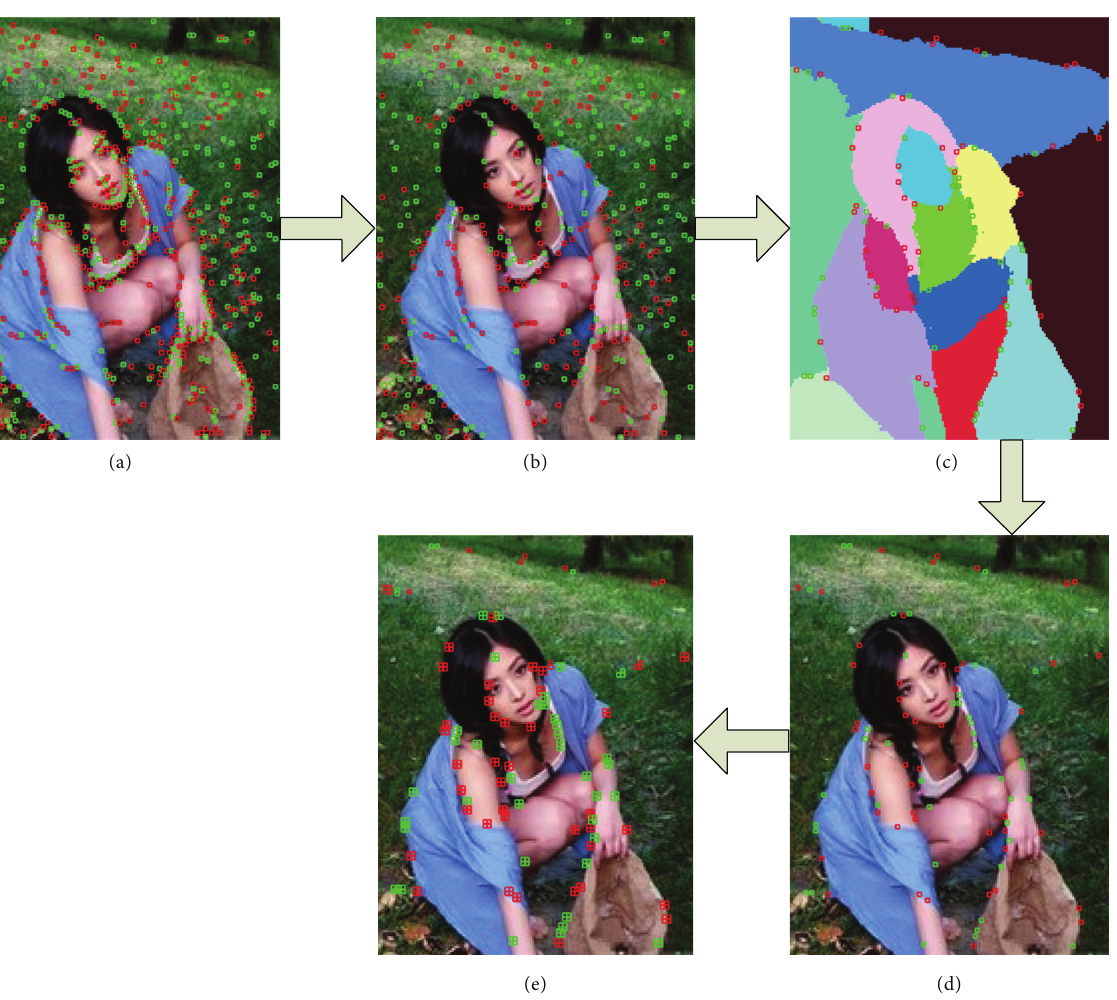
Figure 2: Basic procedure of the keypoints filter. (a) Initial result of difference of Gaussian (DoG). (b) Candidate points we get through the 5 × 5 filter. (c) Information of edges. (d) Information of edges on the original image. (e) Result of candidate points rebuild.